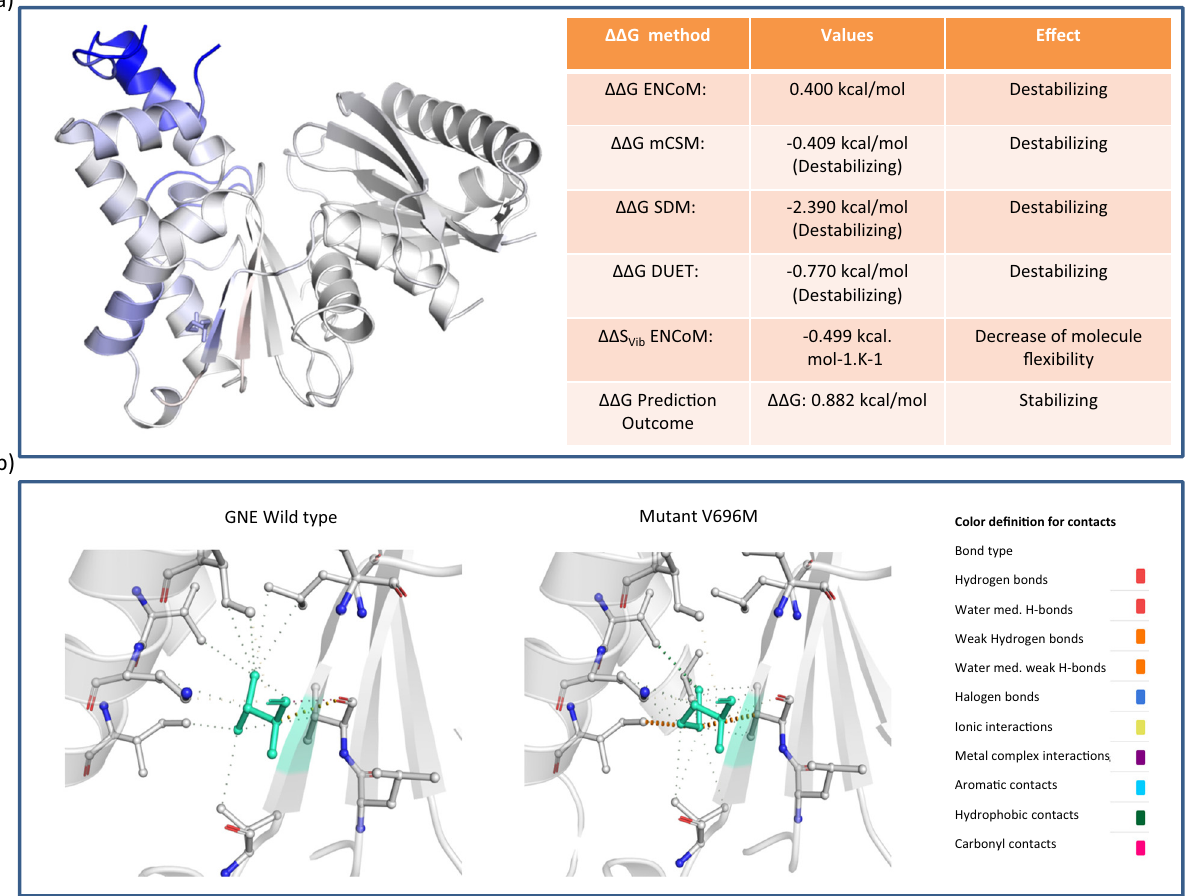
Figure 2: DynaMutanalysisresults: ( a ) Δ Gpredictionoutcomeusingdi ff erentmethods ( aminoacidscoloredaccordingtovibrationalentropychange upon mutation, here blue color represents a rigidi fi cation of the structure ) ; and ( b ) interaction associated changes in GNE WT and Mut